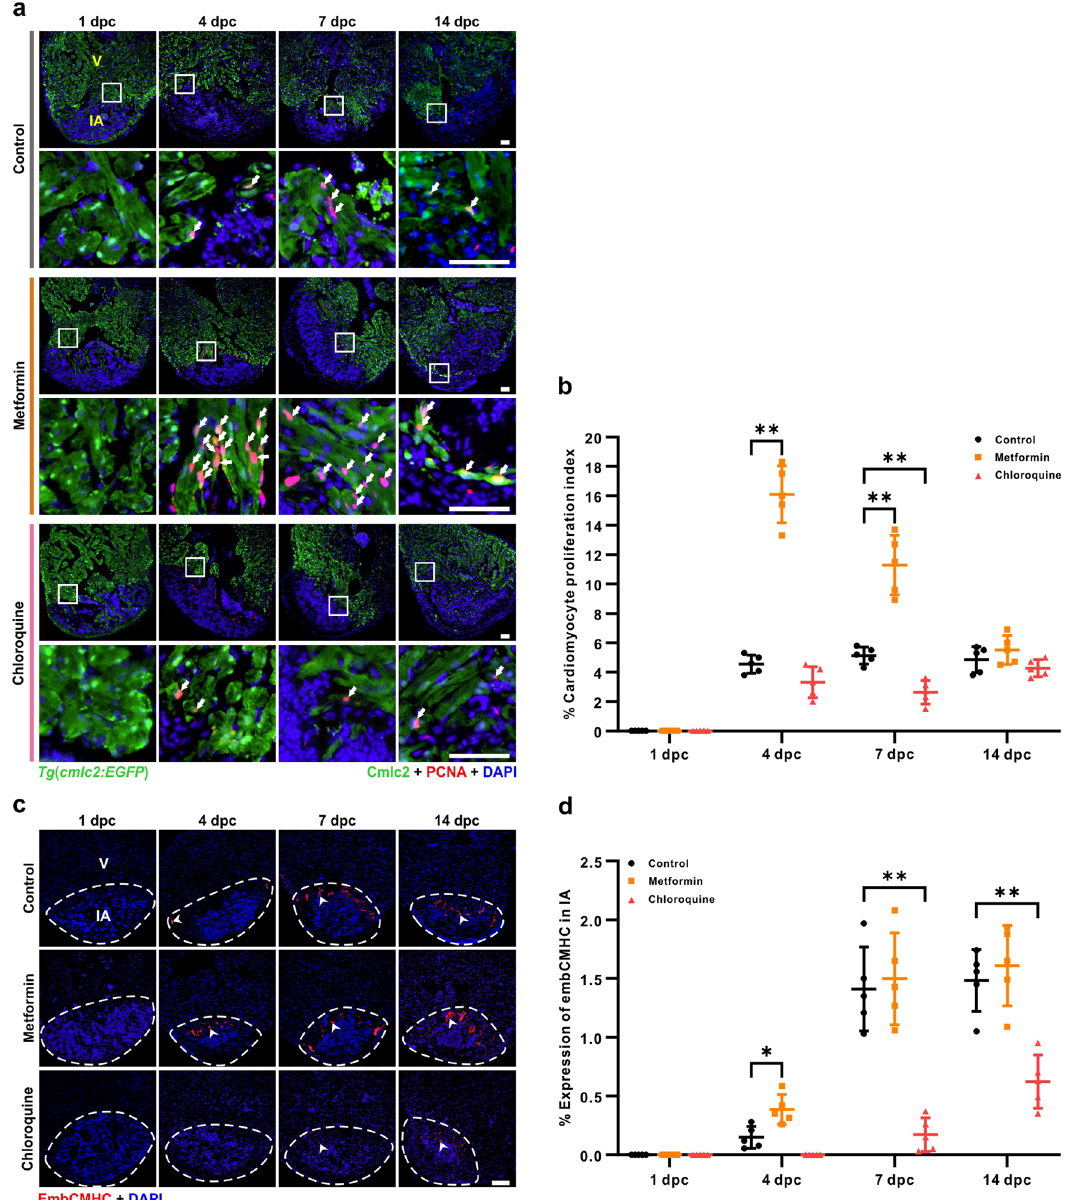
Fig. 3 Metformin accelerates regeneration of the myocardium. a, b After cryoinjury, the Tg ( cmlc2 : EGFP ) fi sh were maintained in untreated fi sh water (control) or in fi sh water containing 50 µM metformin or 100 µM CQ for the indicated days. The hearts were then isolated, fi xed, sectioned and dual-immunostained with an anti-GFP antibody to identify the cardiomyocytes (in green) and an anti-PCNA antibody to identify proliferating cells (in red), after which they were co-stained with DAPI to label the nuclei (in blue). V: ventricle; IA: injured area. The white arrows show the proliferating cardiomyocytes. Scale bars: 50 µm ( a ). The proliferating cardiomyocytes in the untreated control, metformin and CQ treated fi sh at 1 dpc, 4 dpc, 7 dpc, and 14 dpc were quanti fi ed. The data are presented as mean ± SD, n = 5 hearts, ** P < 0.01 vs control ( b ). c , d After heart cryoinjury, AB fi sh were maintained in untreated fi sh water (control) or in fi sh water containing 50 µM metformin or 100 µM CQ. The hearts were prepared, and immunostained with an anti-embCMHC (N2.261) antibody for the identi fi cation of embryonic cardiac myosin heavy chain (in red) and then they were labeled with DAPI. The arrowheads show the signal of embCMHC. Scale bar: 100 µm ( c ). The per c entage of embCMHC positive cells in the control, metformin and CQ treated fi sh at 1 dpc, 4 dpc, 7 dpc, and 14 dpc was quanti fi ed. The data are presented as mean ± SD, n = 5 hearts, * P < 0.05, ** P < 0.01 vs control ( d